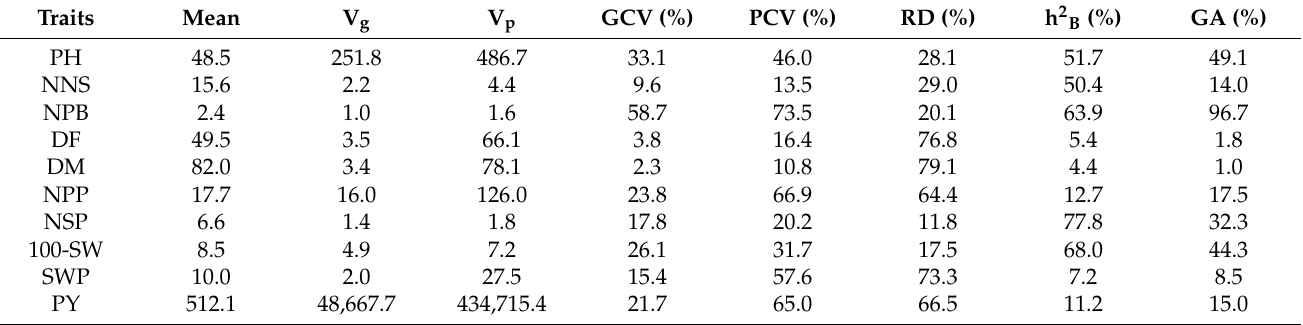
Table 3. Variance components, heritability, and genetic advance for agronomic and yield traits.